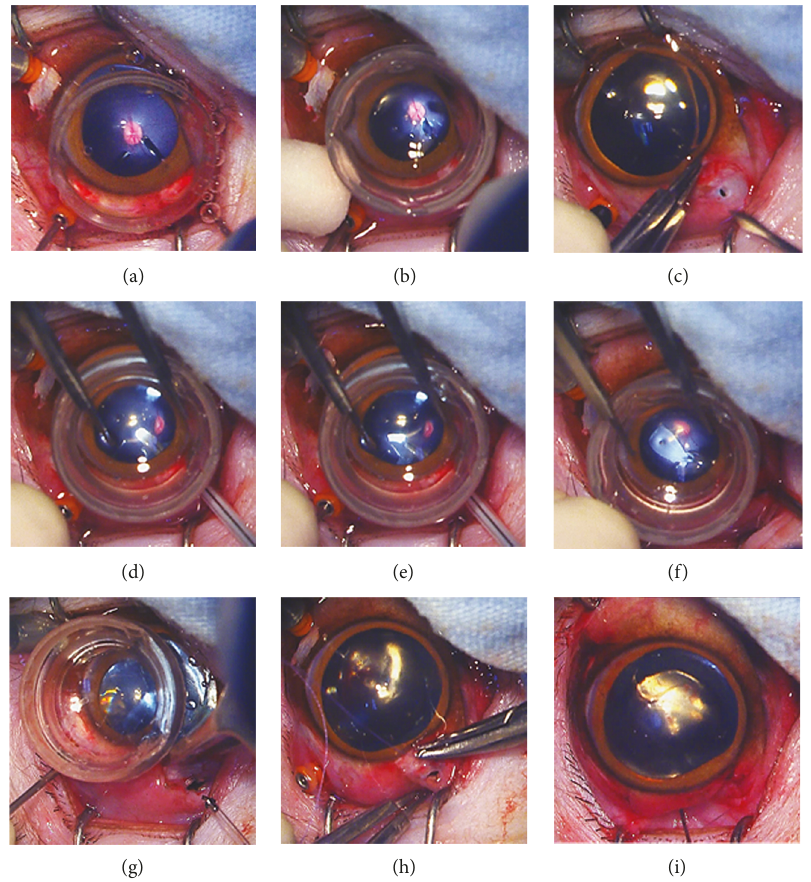
Figure 5: The procedure for rhesus epiretinal implantation. (a) General 23G vitrectomy. (b) Gas-liquid exchange. (c) Sclerotomy enlarging. (d, e) Injecting the epiretinal implant. (f) Flattening the implant with the progenitor side against the host retina. (g) Retinal tack insertion. (h) Closing the scleral and conjunctival incision. (i) Postoperative antibiotics